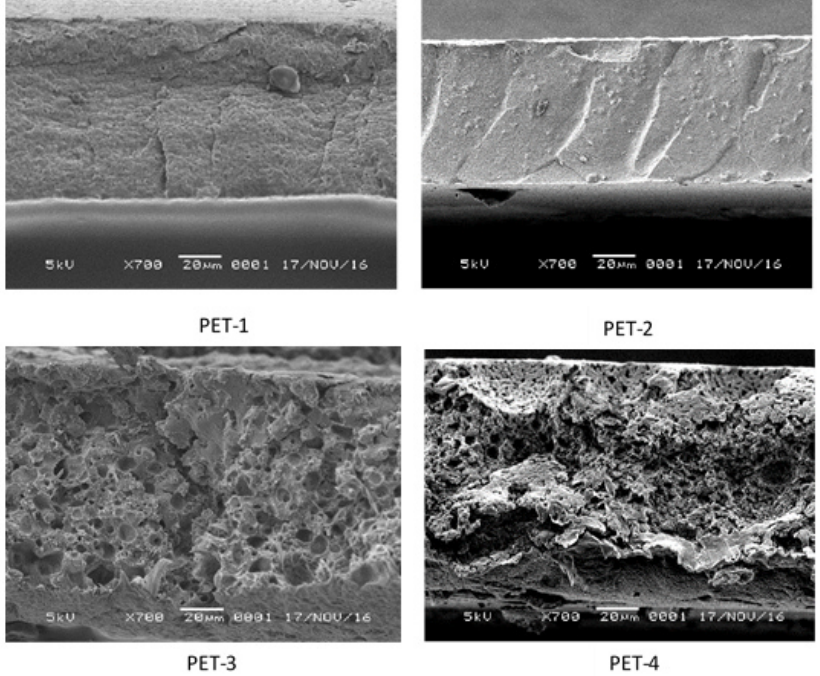
Figure 3. Scanning electron microscopy images of the cross-section of PET membranes. PET-1, no added PVP or evaporation; PET-2, no added PVP and 7 minutes of evaporation; PET-3, added PVP and no evaporation; added PET-4, PVP and 7 minutes of evaporation.